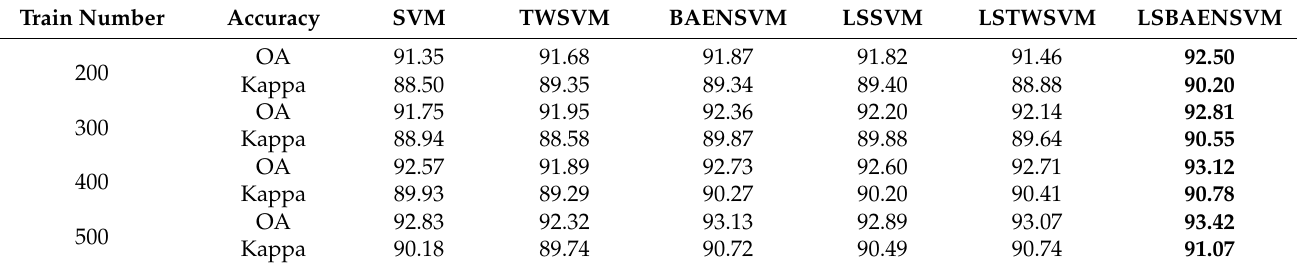
Table 6. Classification results of Pavia University hyperspectral images.